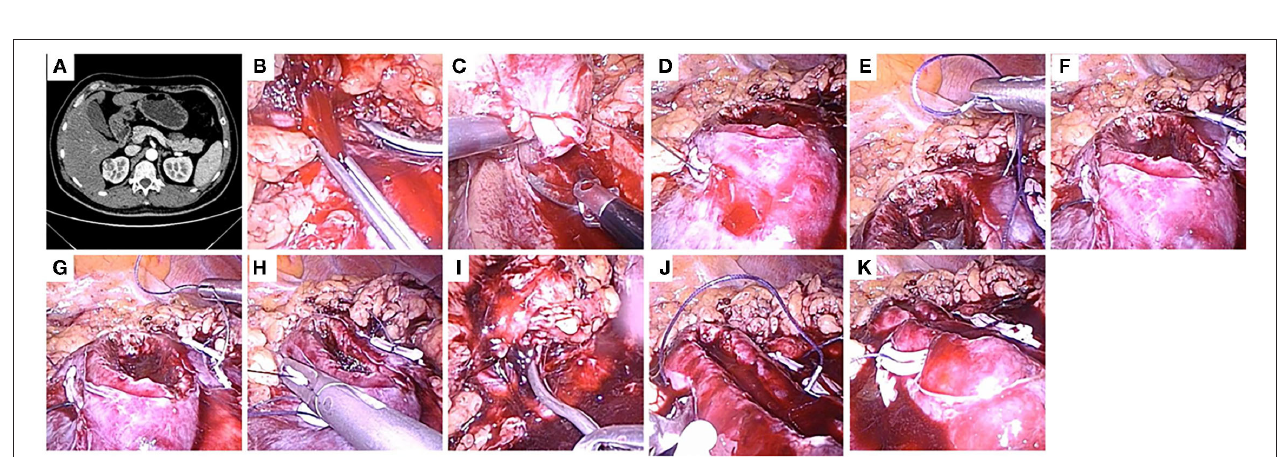
FIGURE 3 | The use of the modified two-layer suture in a right kidney. (A) A 2.8-cm-diameter, mesophytic tumor located at anterior side of a right kidney, and the modified two-layer suture technique was performed. A crosssection of computed tomography (CT) scan. (B) The renal artery was clamped. (C) The tumor was removed by a scissors. (D) The inner layer was closed by continuous suture, and the tail of the suture was secured by a Hem-o-Lok. (E–G) The modified two-layer suture was used to close the outer layer, the initial figure-of-eight suture was begin at the central point of the outer layer. (H) The inserting and removing points of the sutures were secured by Hem-o-Lok clips, so that the two sides of the outer layer were attached closely to each other. (I) The clamp was removed to restore kidney perfusion. (J) The sutures were continuously run from one end to the other end in the outer layer. (K) The kidney wound was closed.